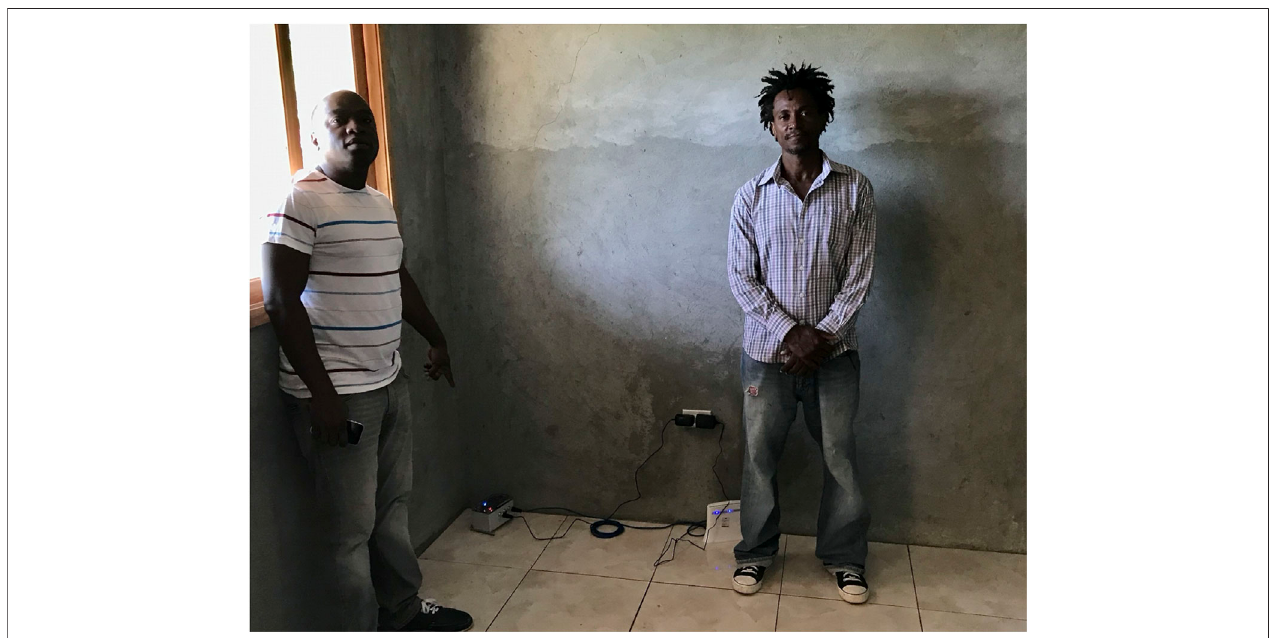
FIGURE 2 | Example of a Raspberry Shake (RS) station installed in Jérémie ( Figure 1 ) with its host on the right, M. Guild Mézile, a local farmer. The instrument is placed on the ground fl oor of his home, with good access to electricity — thanks to a local generator — and to the internet. Steeve Symithe is pointing at the RS station, with the internet modem on the fl oor just behind the host. This station has been up and running 75% of the time since it was installed on September 11, 2019. Written informed consent was obtained from the individuals for the publication of any potentially identi fi able images or data included in this